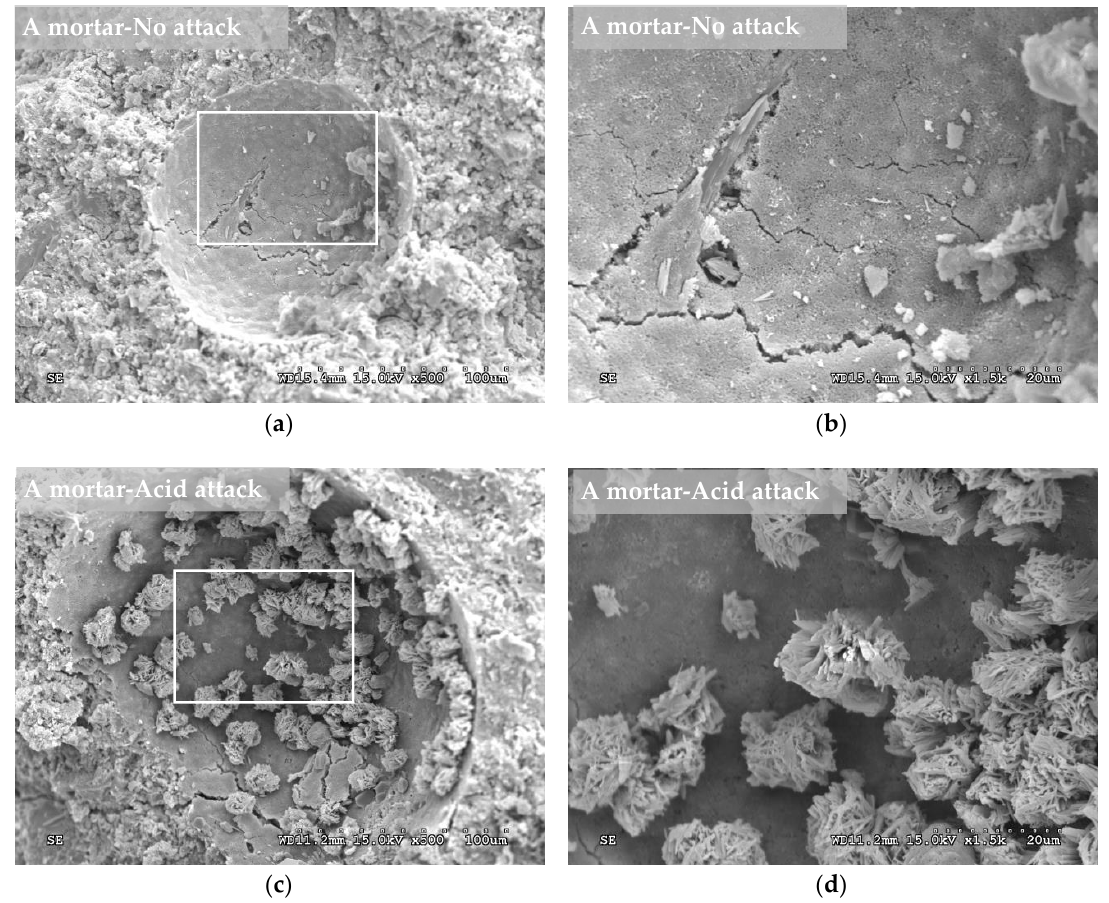
Figure 9. SEM images performed at 84 days (12 weeks) from the mortar manufacture. Left ( a , c ): images at 500 × magnification. Right ( b , d ): zoom at 1500 × magnification on the left image square. Top ( a , b ): mortar type A (0% of crystalline admixture) kept in a nonaggressive environment. Bottom ( c , d ): mortar type A exposed to a sulphuric acid attack for 56 days (8 weeks).